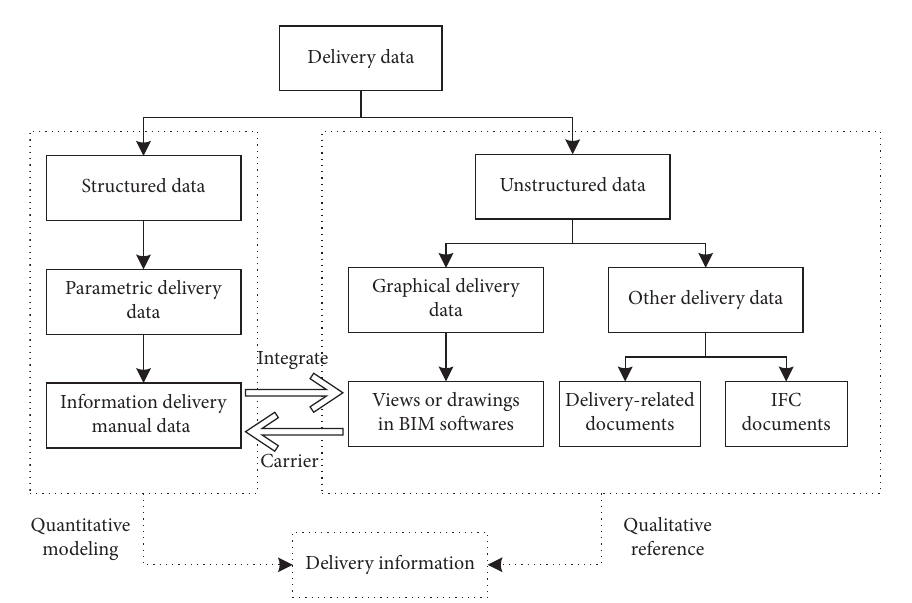
Figure 12: Data classification of delivery information.